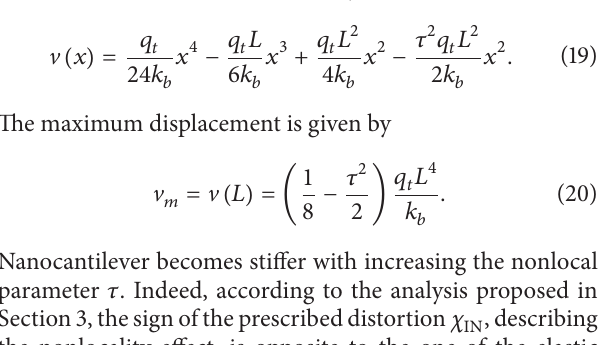
Figure 1: Dimensionless transverse displacements V ∗ for the nanocantilever versus 𝜉 for 𝜏 ∈ {0,0.05, 0.1, 0.15, 0.2, 0.3, 0.5} .